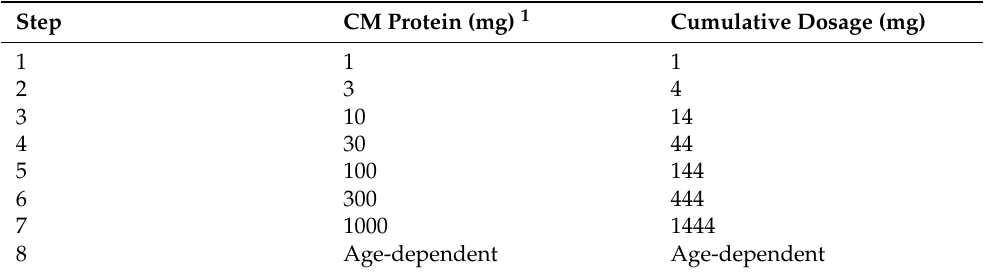
Table 2. Dosages in double-blind, placebo-controlled cow’s milk challenge, including the cumula- tive